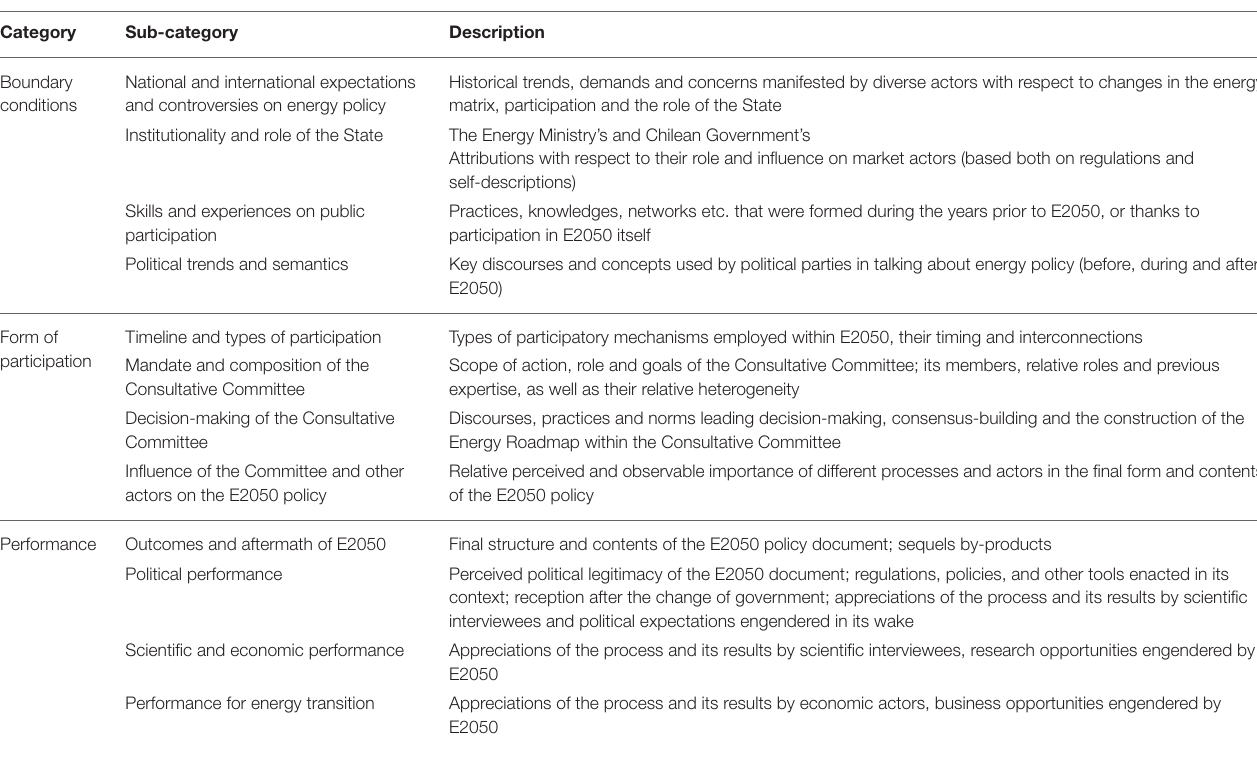
TABLE 3 | Codification